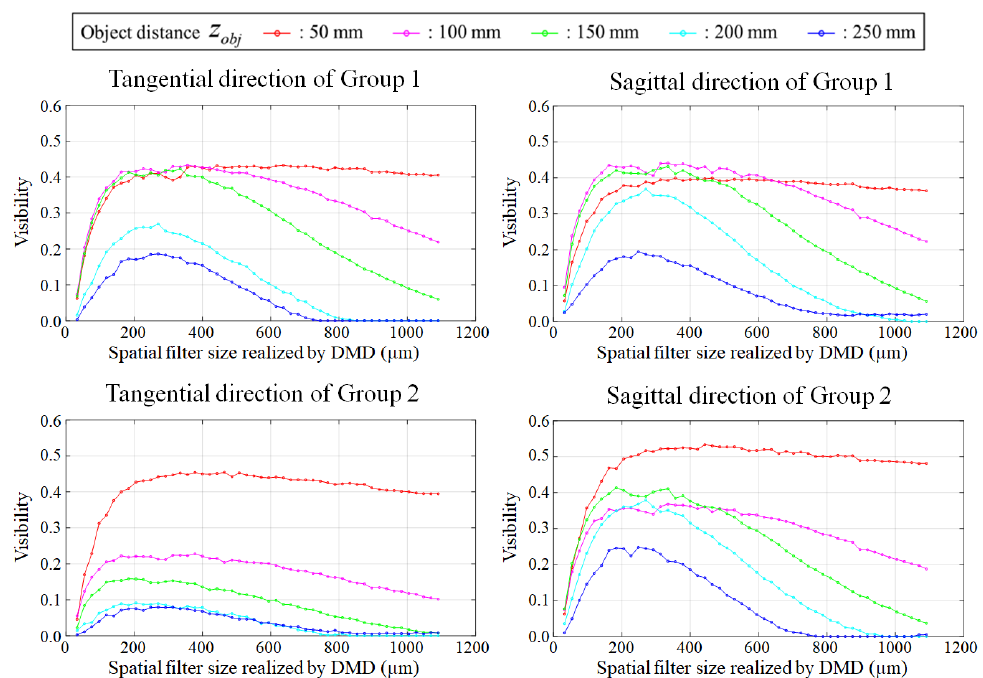
Figure 10. Visibility depending on the sagittal and tangential directions. Consequently, the optimal spatial filter size (OSFS) was estimated to be between 200 and 400 µm. In the tangential direction of group 1, the OSFS for reconstruction at object distances of 50, 100, and 150 mm was around 350 µm because there was the highest visibility around the area. In the case of reconstructing at object distances of 200 and 250 mm, the OSFS was around 270 µm. In the tangential direction of group 2, the OSFS was considered as 400 µm when object distances were 50 and 100 mm. In the case of object distances of 150, 200, and 250 mm, the OSFS was around 200 µm. Similarly, the OSFS was obtained depending on the object distances in the sagittal direction. In group 1, in the case of object distances of 50, 100, and 150 mm, the OSFS was around 350 µm. When object distances were 200 and 250 mm, the OSFS was 270 µm. In the case of group 2, the OSFS was around 450 µm with an object distance of 250 mm. Also, we estimated an OSFS of 300 µm at the object distances of 100, 150, and 200 mm. In case of an object distance of 250 mm, the OSFS was around 250 µm. These results indicate the OSFS differs according to object distances and it is hard to decide the OSFS. However, among the specification of a holographic display, the expressible object distance range is an important characteristic. An increase of the spatial filter size induces a narrowing of the expressible object distance range, and this is demonstrated in our experiments. Therefore, we obtained the OSFS by analyzing a figure of merit which is the negative of the sum of the measured visibilities according to the spatial filter size, 𝑟 (cid:3046) , and the figure of merit, 𝑀 , is calculated by 𝑀(cid:4666)𝑟 (cid:3046) (cid:4667) = − ∑ 𝑣(cid:3435)𝑟 (cid:3046) , 𝑧 (cid:3042)(cid:3029)(cid:3037) (cid:3439) (cid:3053) (cid:3290)(cid:3277)(cid:3285) , (10) where a figure of merit, 𝑀 , signifies the criterion that a hologram can be accurately expressed. This indicates that the smaller the value, the better the hologram is expressed. Figure 11 shows the figure of merit, 𝑀 , depending on the spatial filter size. Blue circles denote the figure of merit of the measured result corresponding to the spatial filter size, and a blue line is a regression result of the figure of merit values. Considering the tendency of visibility of Figure 10, there is no significant change between 200 µm and 400 µm in Figure 11. When the spatial filter size is 270 µm, the figure of merit, 𝑀 , is the minimum value. Therefore, the OSFS is 270 µm, as indicated by the black dotted line in Figure 11.